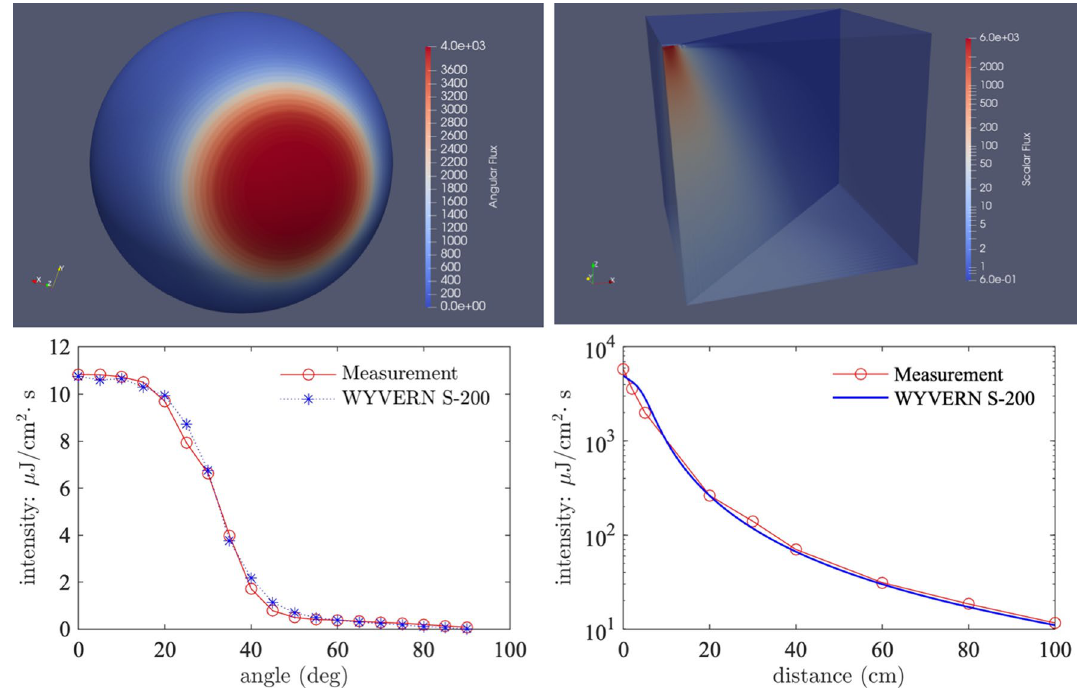
Figure 5. Top left: Angular flux surface source intensity, the value at the spherical surface represents the flux intensity in the direction defined by the angle from the origin of the sphere to its surface. Top Right: Far-UVC scalar flux intensity (fluence rate) through space in units of µ J.cm − 2 .s − 1 . Bottom Left: Far-UVC intensity (fluence rate) as a function of angle at a distance of 1 mfrom the light source. Bottom Right: Far-UVC intensity (fluence rate) as a function of distance from the light